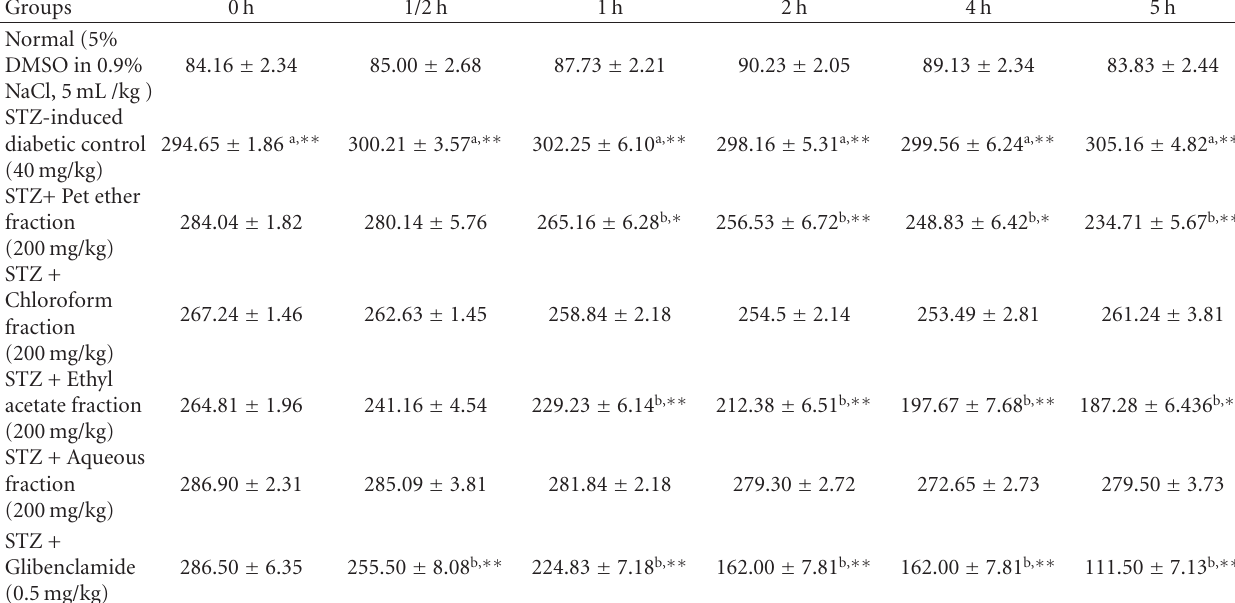
Table 1: E ff ect of various fraction of ethanol extract of Stereospermum suaveolens on glucose level by acute treatment in STZ-induced diabetic